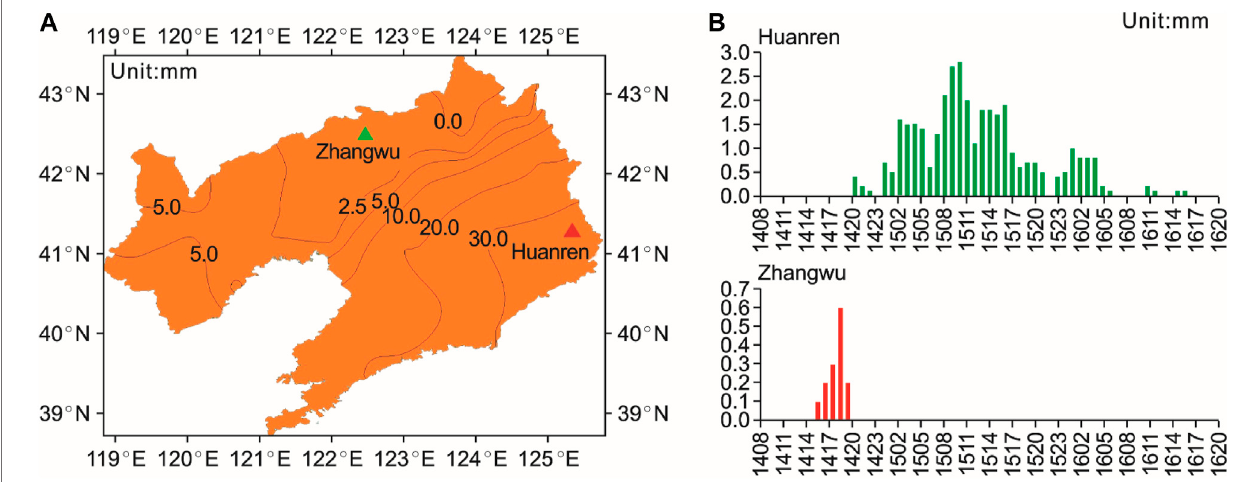
FIGURE 2 | Snowfall characteristics in Liaoning province (A) and the snowfall process at Huanren and Zhangwu stations (B) .